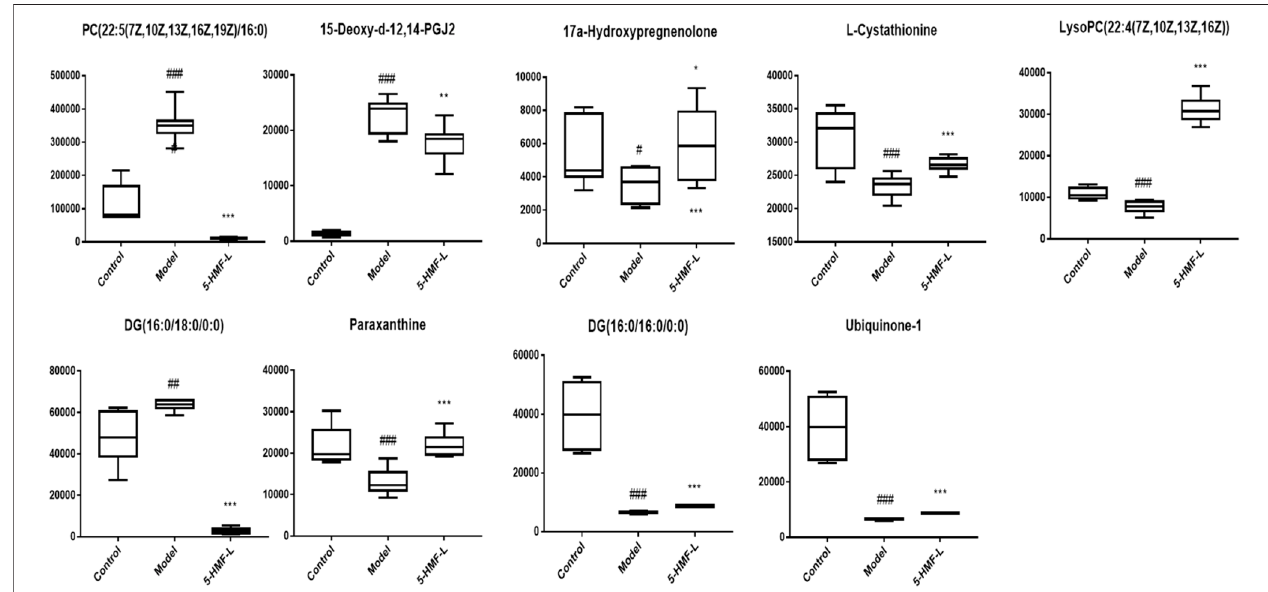
FIGURE7 | Comparison ofthe relative content ofdifferentmetabolites in plasma of thedifferent administration groups. All data are expressed as mean ± standard deviation ( n (cid:1) 8). # p < 0.05, ## p < 0.01, ### p < 0.001 compared with the control group; *p < 0.05, ***p < 0.001 compared with the model group.